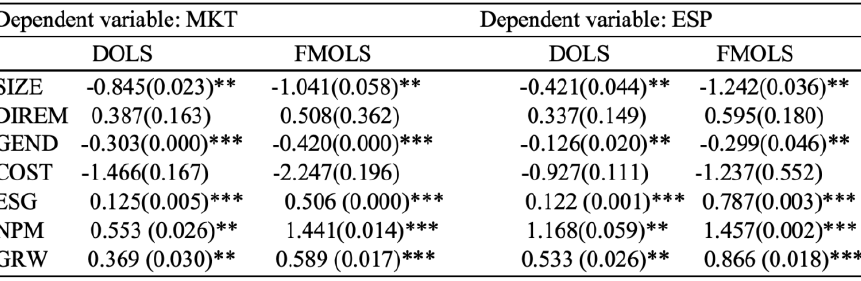
Table 5: Panel DOLS and FMOLS estimation results